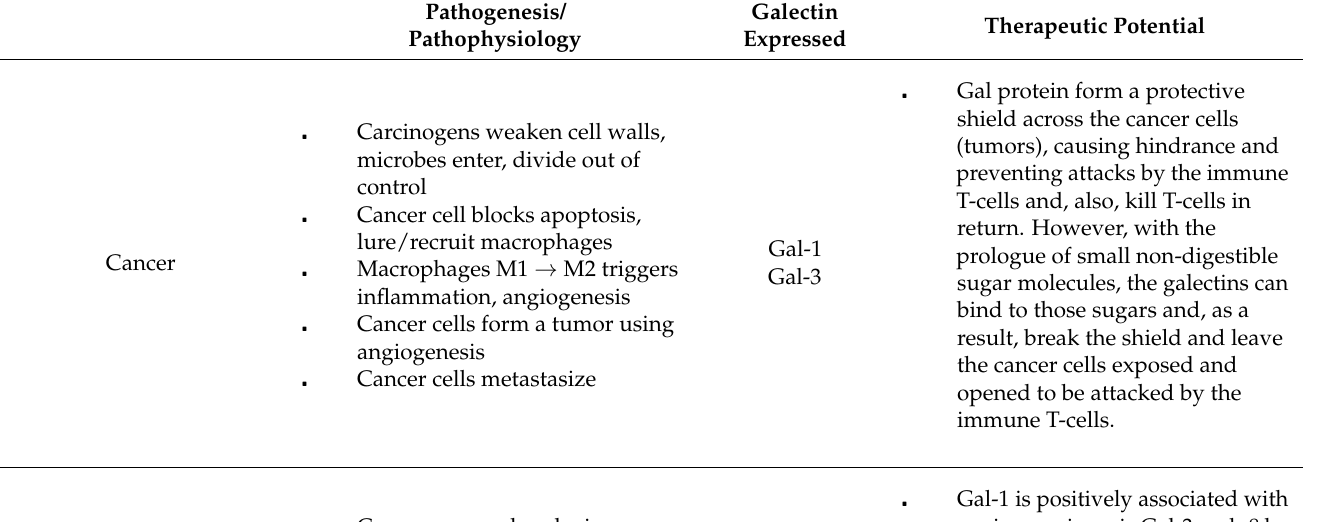
Table 2. Pathogenesis of numerous diseases and potential therapeutic effects of different